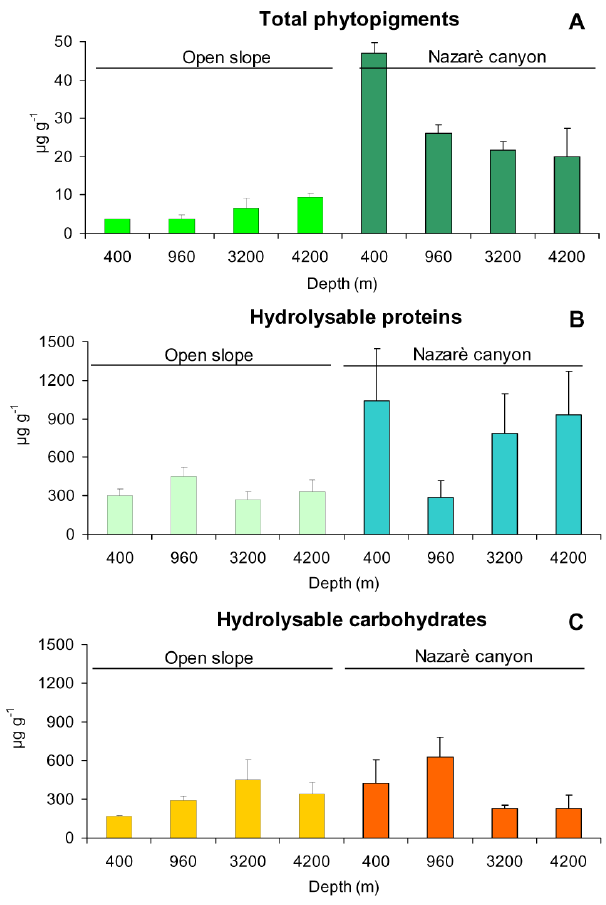
Fig. 5. Spatial distribution of (A) total phytopigment concentra- tions, (B) enzymatically hydrolysable protein and (C) carbohydrate pools in surface sediments of the Nazar`e canyon and adjacent open slope of the Portuguese margin. Standard deviations are